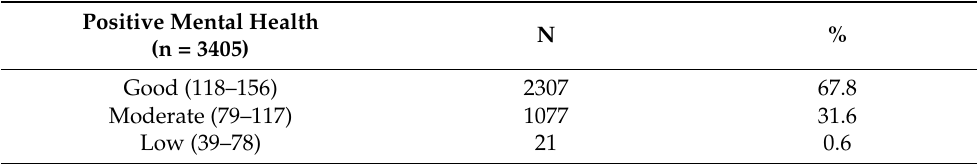
Table 2. Levels of positive mental health.